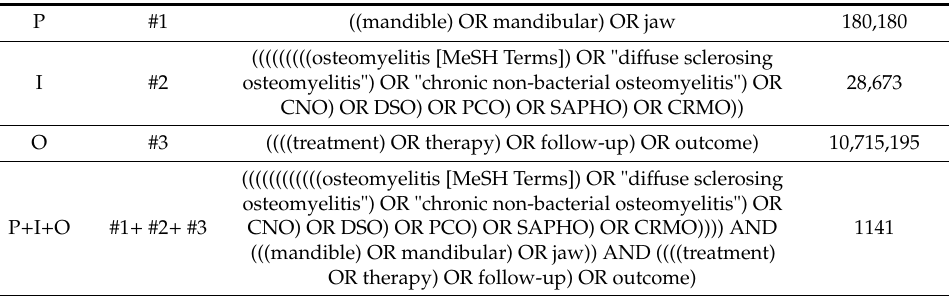
Table 1. Search strategy on PubMed